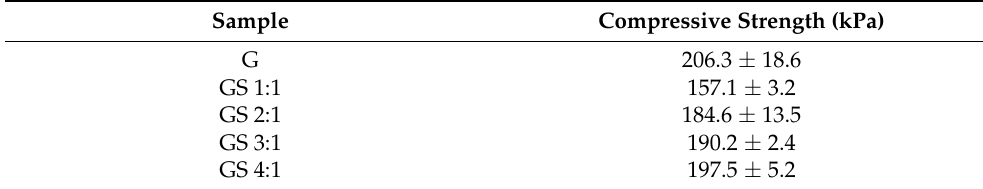
Table 1. Compressive strength of gelatin (G) and gelatin–siloxane monoliths